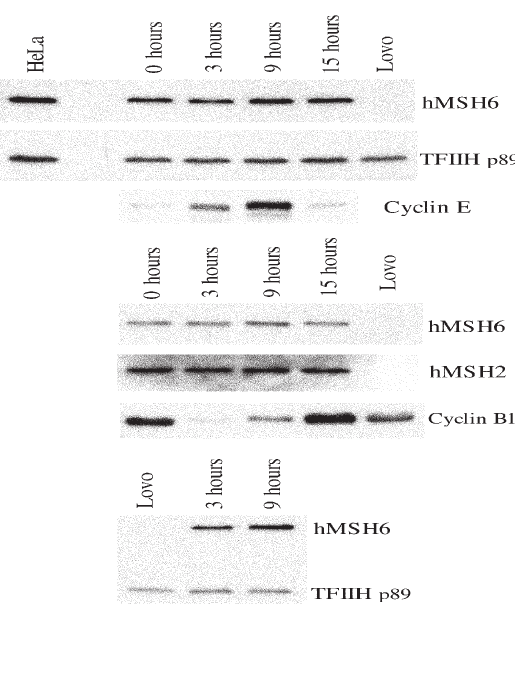
Western blot analysis of proteins extracted from HeLa-S3 cells at different time points after mitosis. The steady-state levels of hMSH6 and hMSH2 are high in every phase of the cell- cycle, although a consistent increase (25%, p = 0.01) of hMSH6 was always observed when cells entered S phase (compare 3 h vs 9 h; three of the several blots performed are shown here). Data from three independ- ent experiments were compared with the steady-state level of the housekeeping protein TFIIH p89. Cyclin E and B1 ex- pression was used as a control of cell syn- chronisation. Extracts from HeLa and LoVo cell lines were used as positive and nega- tive controls of hMSH2/hMSH6 expression, respec-